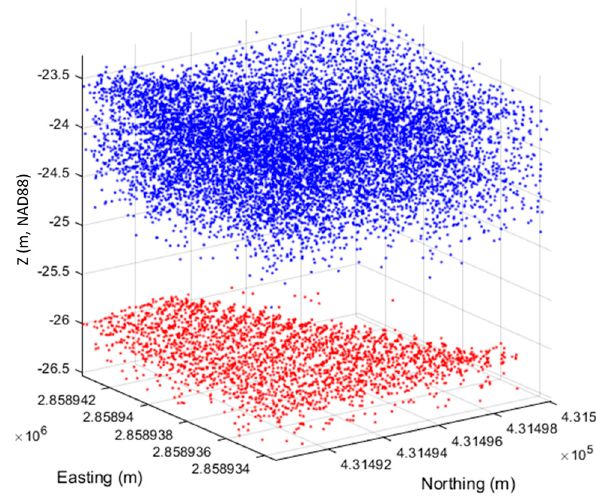
Figure 5. Segmented seafloor (red) and non-seafloor (blue) points.